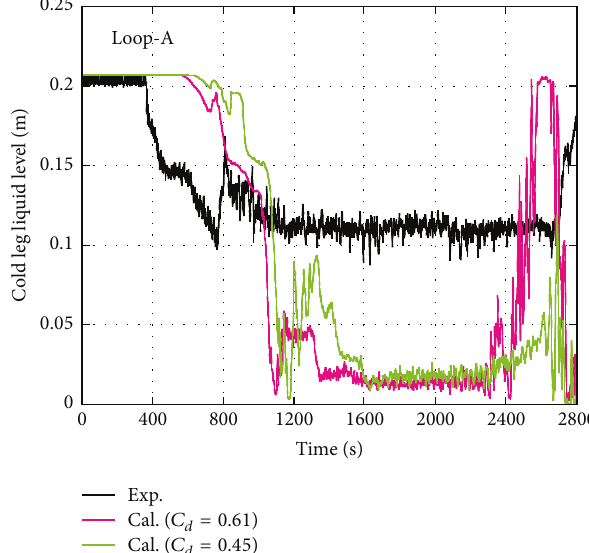
Figure19:LSTFandRELAP5resultsforcoldlegliquidlevelinloop- A in case of no release of dissolved gas.